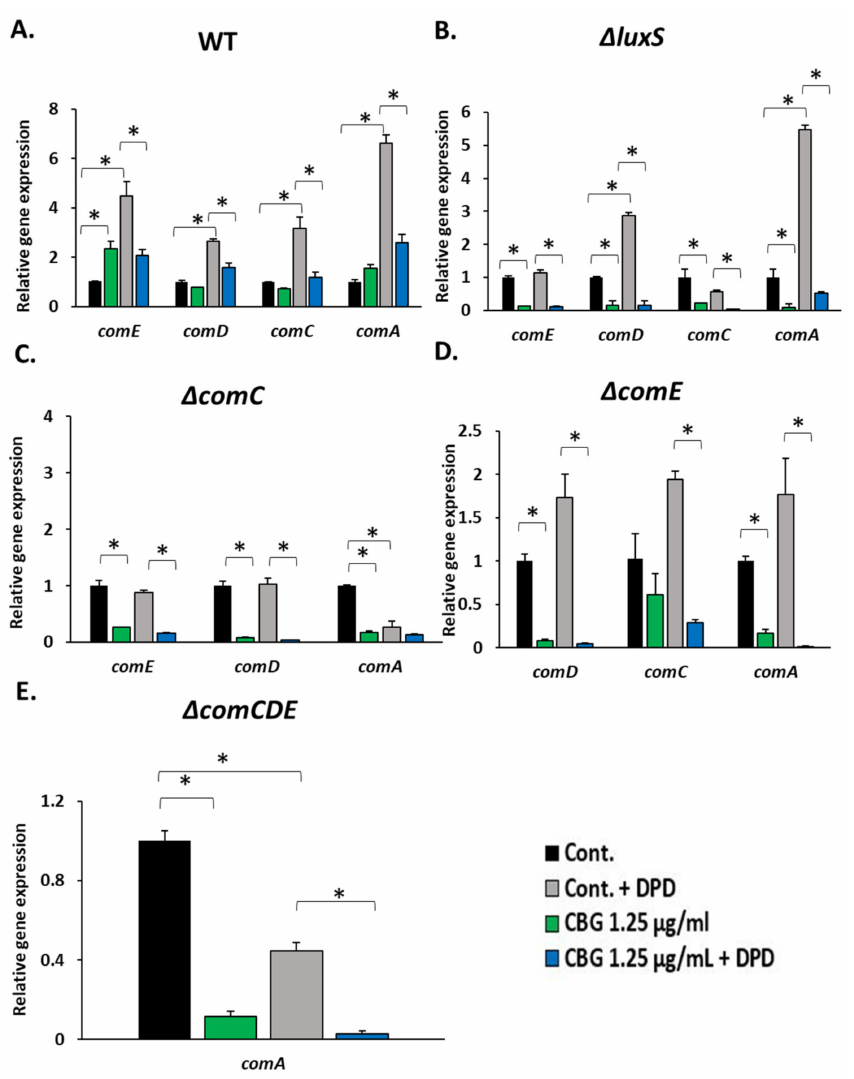
Figure 6. DPD induced the expression of comCDE and comA genes. ( A – E ). Expression of comCDE and comA genes in various S. mutans strains incubated in the absence or presence of 1.25 µ g/mL CBG and/or 5 µ M DPD (pre-AI-2) for 4 h in comparison to control as determined by real-time PCR using respective primers. ( A ). WT; ( B ). ∆ luxS ; ( C ). ∆ comC ; ( D ). ∆ comE ; and ( E ). ∆ comCDE . n = 3; * p <